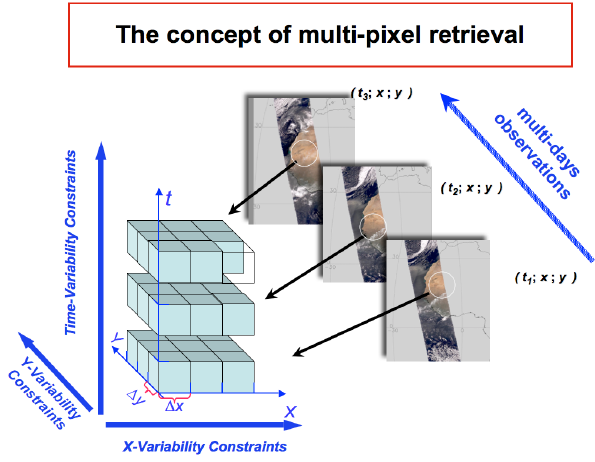
Fig. 6. The diagram illustrates the approach for retrieval aerosol from a multiple pixels of